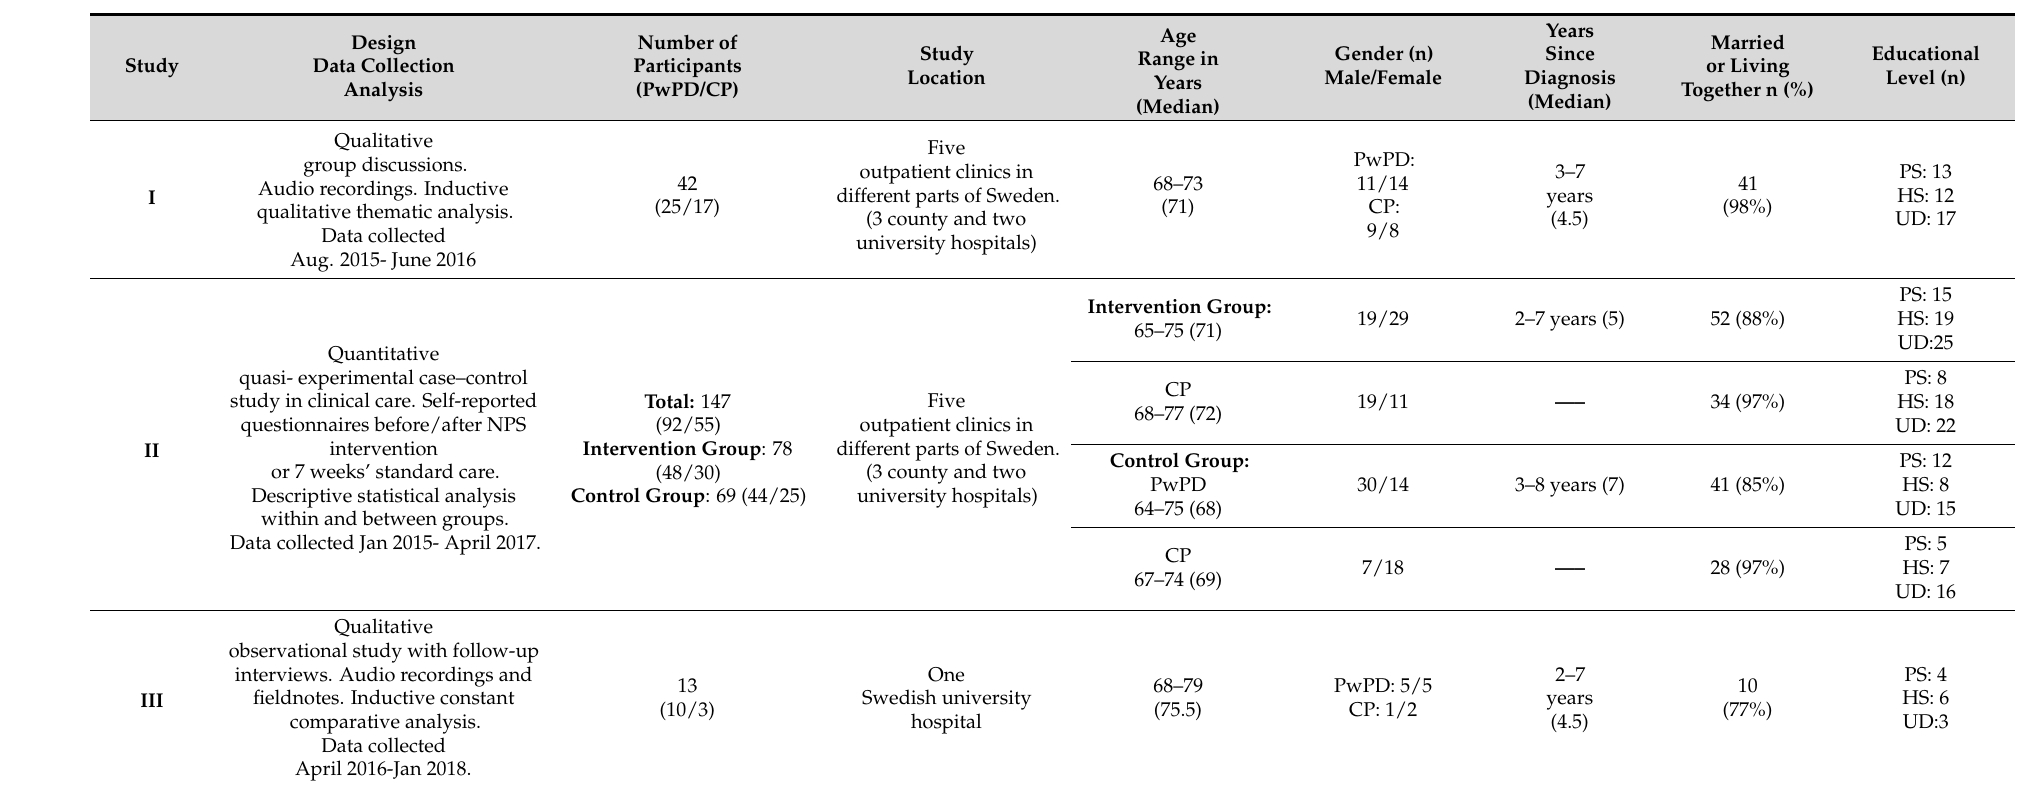
Table 1. Summary of design and participants for studies included in